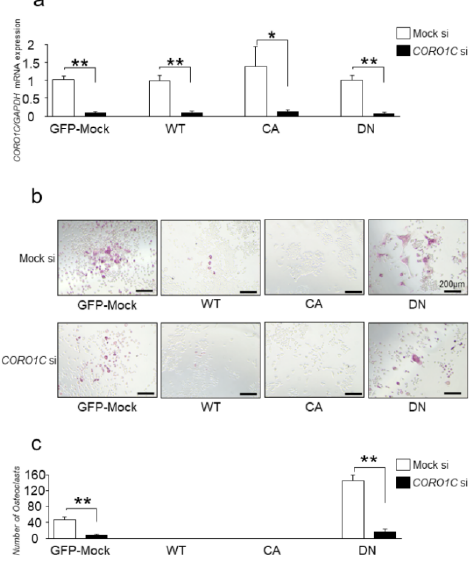
Figure 5. Effects of Coronin1C knockdown and Rab44 overexpression on osteoclast differentiation. ( a ) GFP-Mock, WT, CA and DN expressed RAW-D cells were transfected with CORO1C siRNA (Coronin1C si), followed by stimulation with RANKL (100 ng/mL) for 3 days. The Coronin1C mRNA levels were analyzed by qPCR. * p < 0.05; ** p < 0.01; compared with the mock cells. ( b ) TRAP staining of the GFP-mock, WT, CA and DN expressed RAW-D cells transfected with Coronin1C si and the Mock si cells after stimulation with RANKL for 3 days. ( c ) The number of TRAP-positive multinucleated osteoclasts, which contained three or more nuclei, was counted. ** p < 0.01; compared to mock cells.